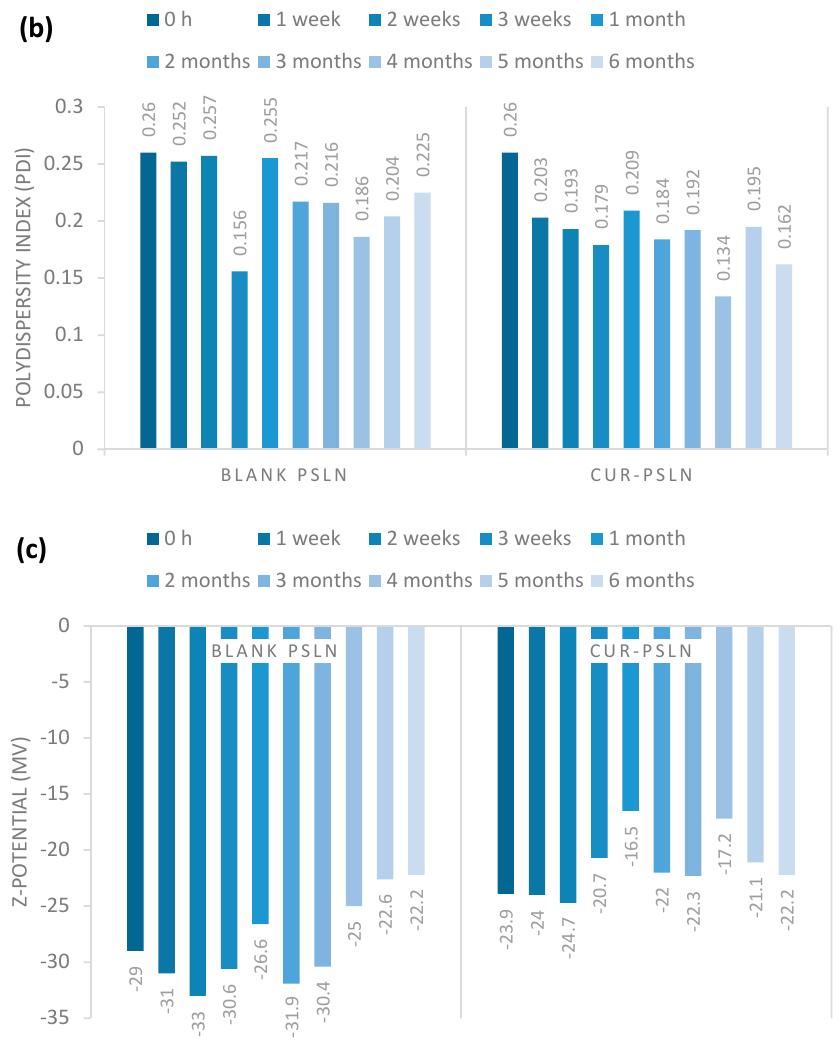
Figure 3. ( a ) Particle size, ( b ) polydispersity index (PDI), and ( c ) Z-potential of blank pSLNs and CUR-pSLNs during storage at room temperature for 6 months.